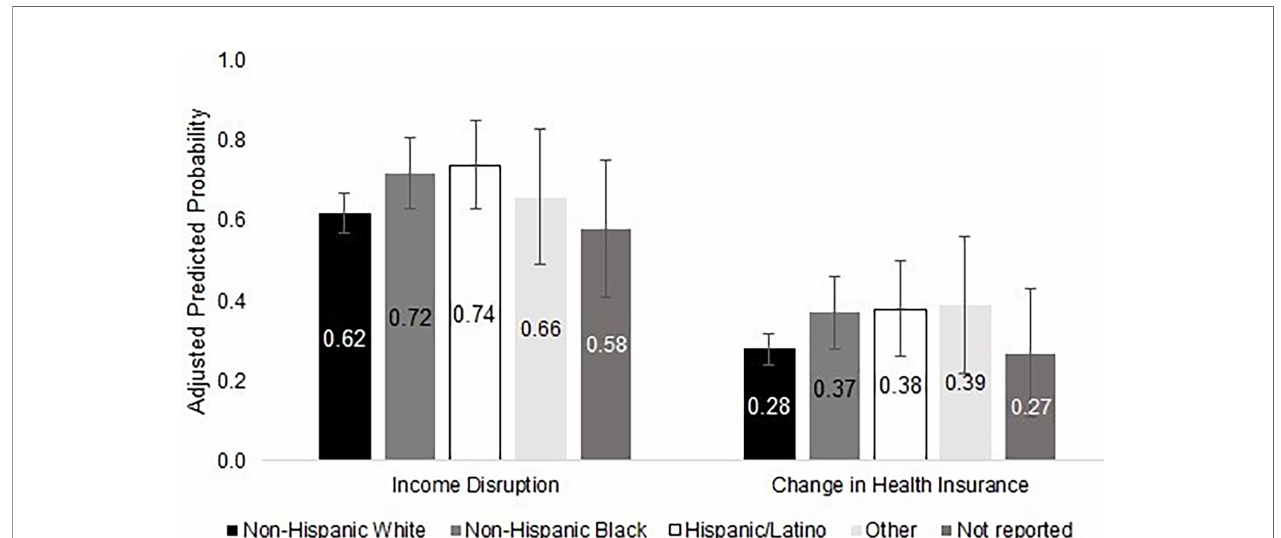
FIGURE 1 | Financial consequences of employment disruption in a sample of employed patients with cancer who received assistance from a national non-pro fi t, strati fi ed by race/ethnicity (Oct – Nov 2019) (N = 619). Figure 1 shows the adjusted predicted probabilities of experiencing substantial income loss and a change in health insurance following employment disruption by race/ethnicity, controlling for clinical characteristics. Adjusted percentages are reported with 95% con fi dence intervals from the multivariable logistic regression using Delta-method calculated standard